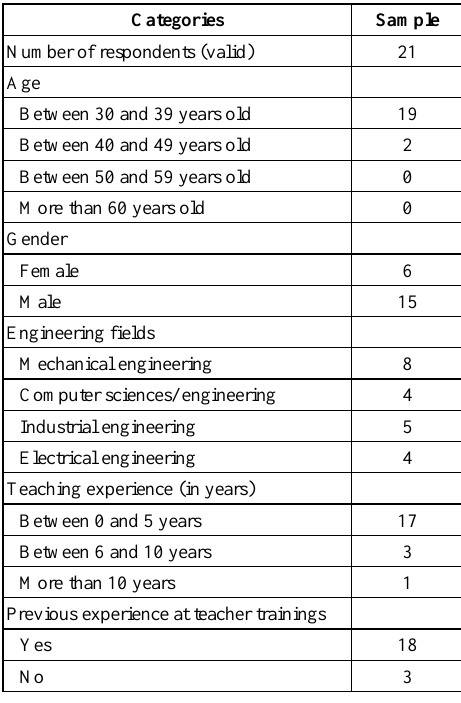
Table 3. Characterization of the